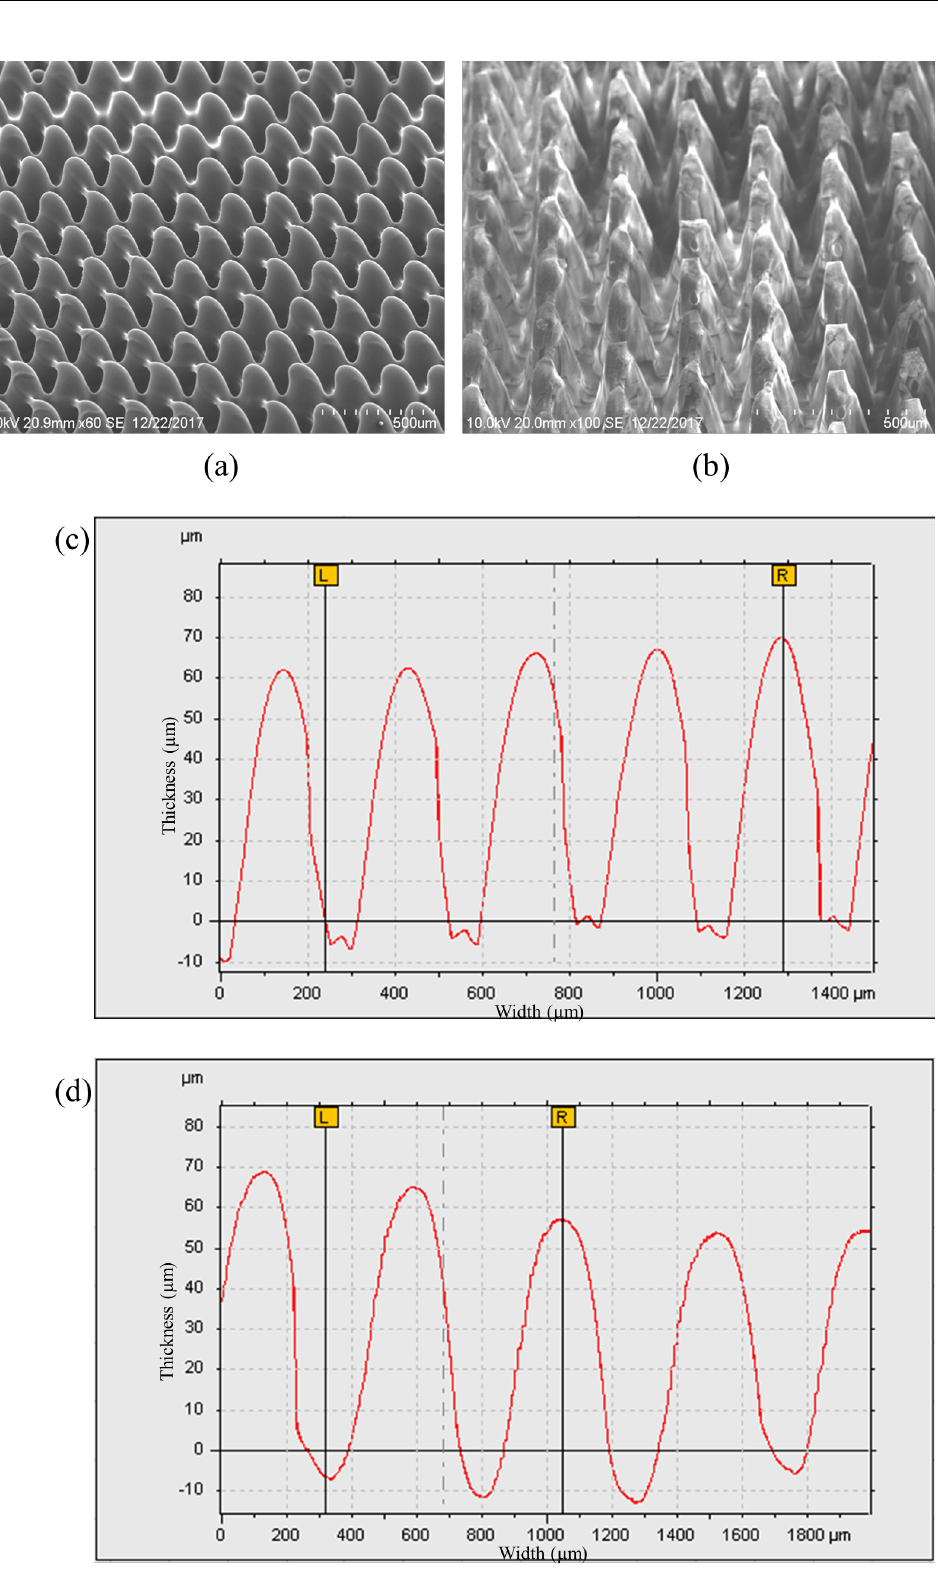
Figure 11. Micropillars with 200 µ m width: ( a ) SU8-10 micropillar master mold, ( b ) replicated PDMS micropillar, ( c ) surface profile of the SU8-10 micropillar master mold, and ( d ) surface profile of the replicated PDMS